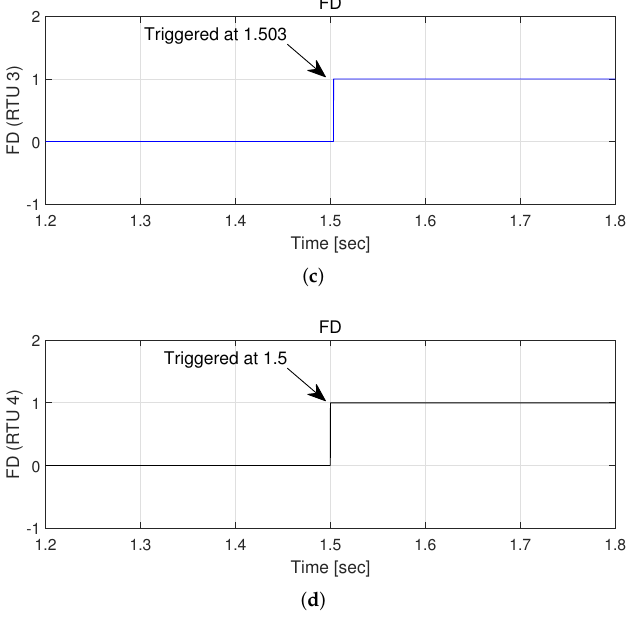
Figure 12. Fault detection performance at each RTU. ( a ) RTU1; ( b ) RTU2; ( c ) RTU3; ( d )